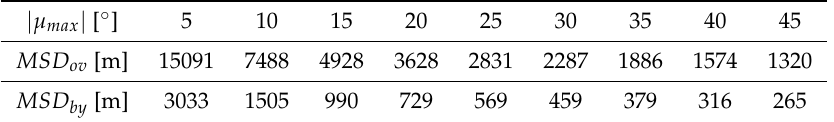
Table 3. Values for minimum stabilization distances for V T = 80 m/s, | ∆ χ max | = 45 ◦ (as used in Section 3) for different values of | µ max | , for fly-over and fly-by